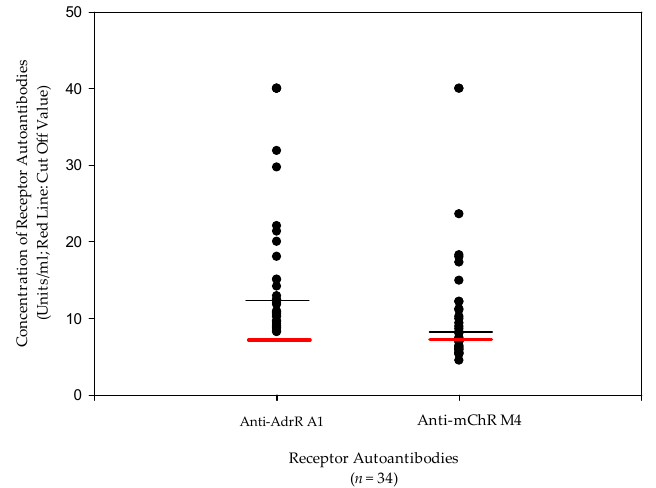
Figure 1. Concentration of adrenergic A1 and muscarinic cholinergic M4 autoantibodies in patients with postural orthostatic tachycardia syndrome. All the subjects included in this study had elevated adrenergic receptor A1 autoantibodies, whereas 19/34 (55.9%) had elevations of muscarinic cholinergic M4 autoantibodies (Pearson’ correlation value r = 0.792).